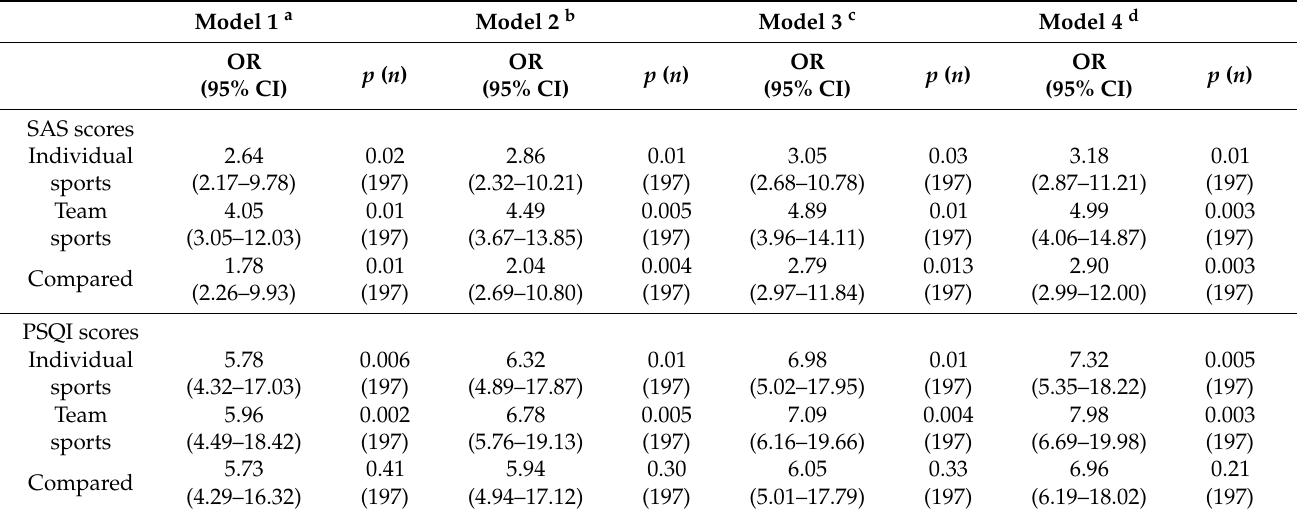
Table 4. Established models and revised models.